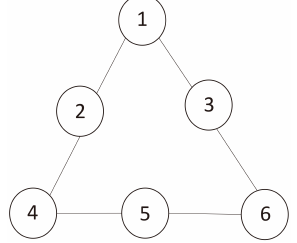
Fig. 1 An undirected